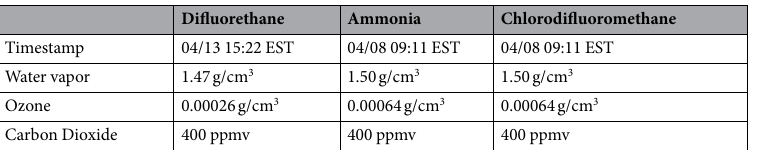
Table 2. Measured values used for Atmospheric compensation.